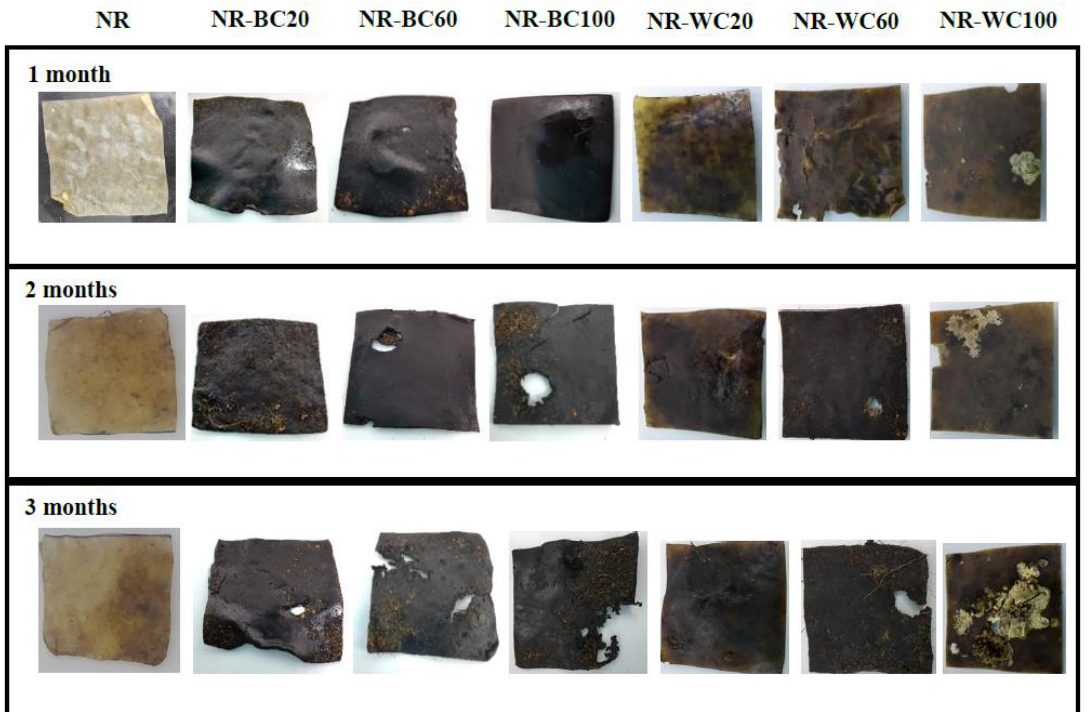
Figure 11. The visual analysis of biodegradation in soil of NR–BC and NR–WC for 3 months.